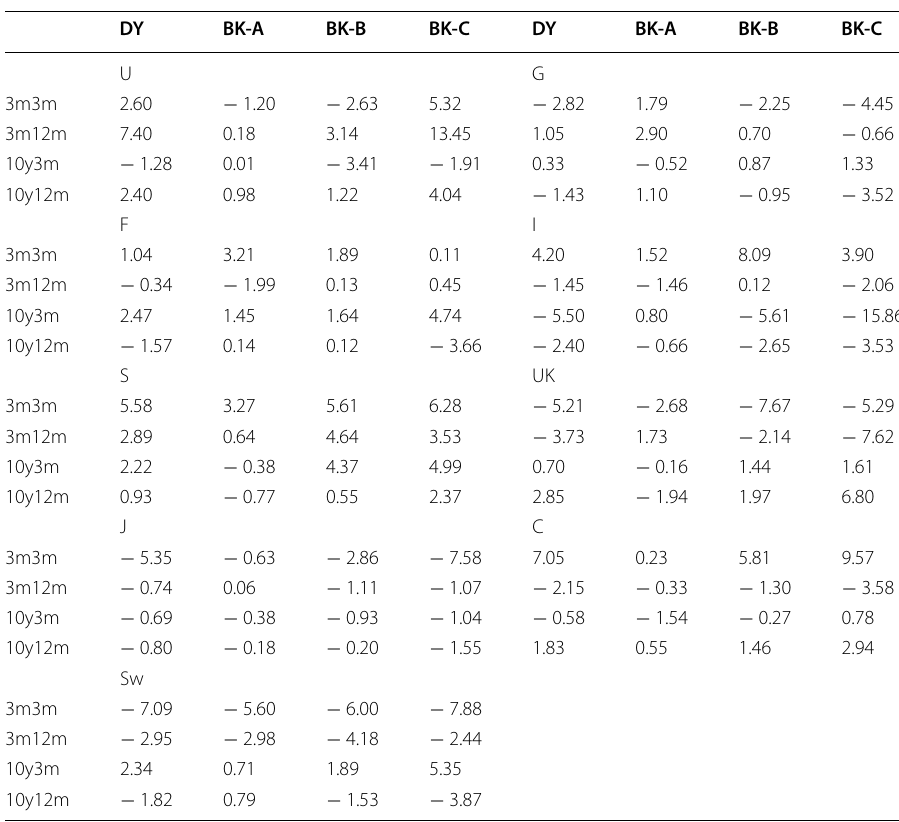
Table 2 Net movements